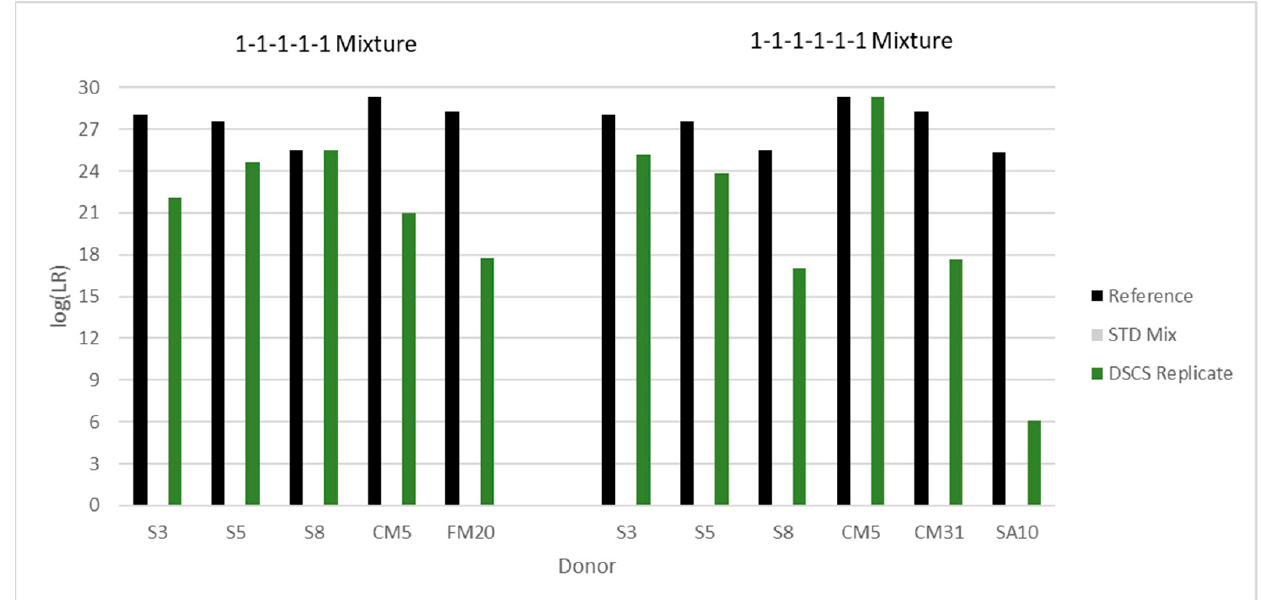
Figure 17. Increased contributor log(LR) recovery in 5 (left panel) and 6 (right panel) person mix- tures by DSCS (EFM) (“DSCS Replicate”). Standard PG mixture analysis (“STD Mix”) could not be conducted on these mixtures due to EFM software limitations. The “Reference” LR is the reciprocal of the random match probability of the single source DNA profile from the known donor. The al- phanumeric characters refer to the individual donors present in the mixture.